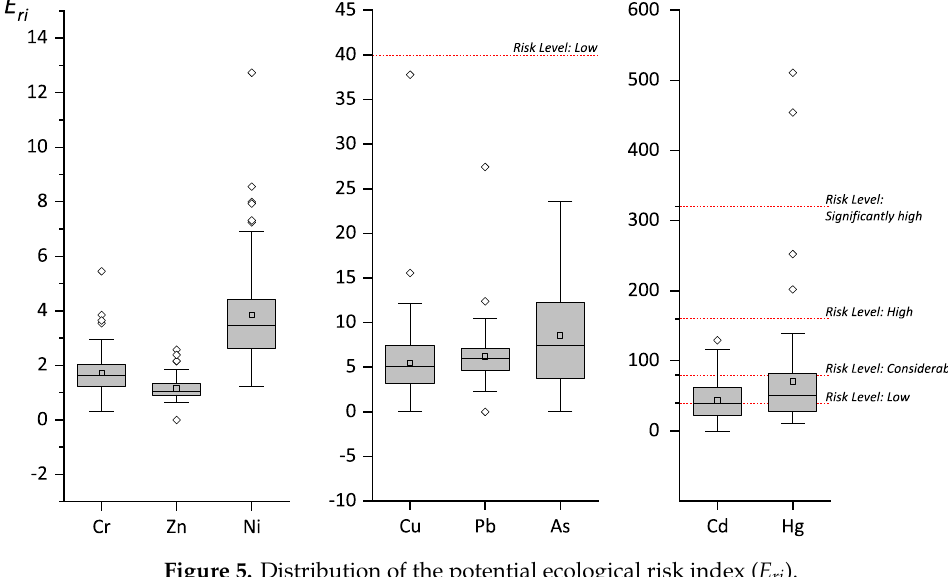
Int. J. Environ. Res. Public Health 2019 , 16 , x FOR PEER REVIEW Figure 5. Distribution of the potential ecological risk index ( E ri ). Figure 5. Distribution of the potential ecological risk index ( E ri ). Table 11. Values of the potential ecological risk index ( E ri ).